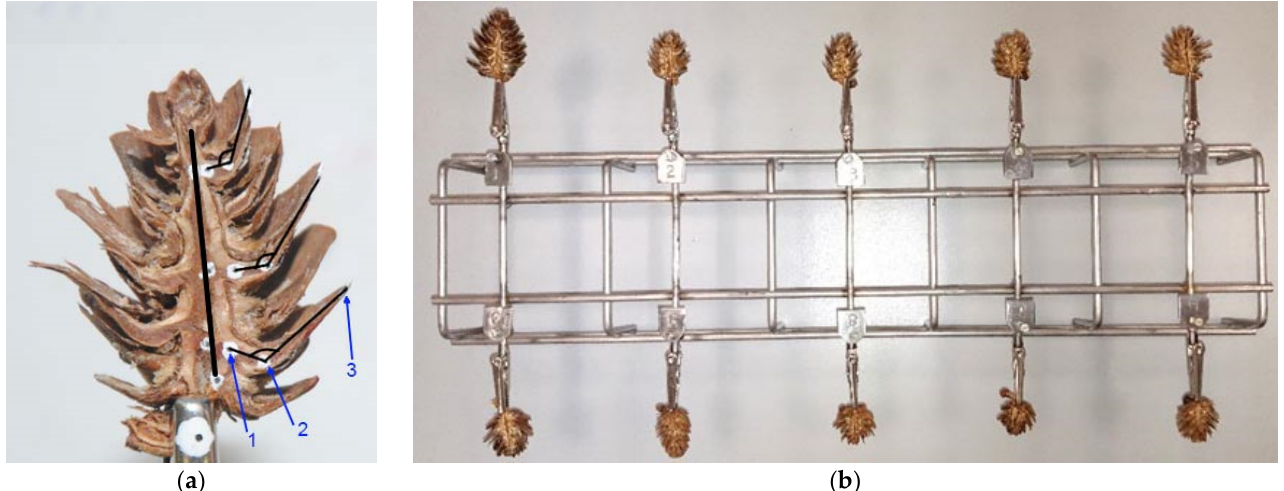
Figure 1. Cone half with marked reference points and axis ( a ), and stand for examining the scale opening angle in ten cone samples ( b ), where: 1—junction of the scale with the cone rachis, 2—point on the scale curve, and 3—scale apex.